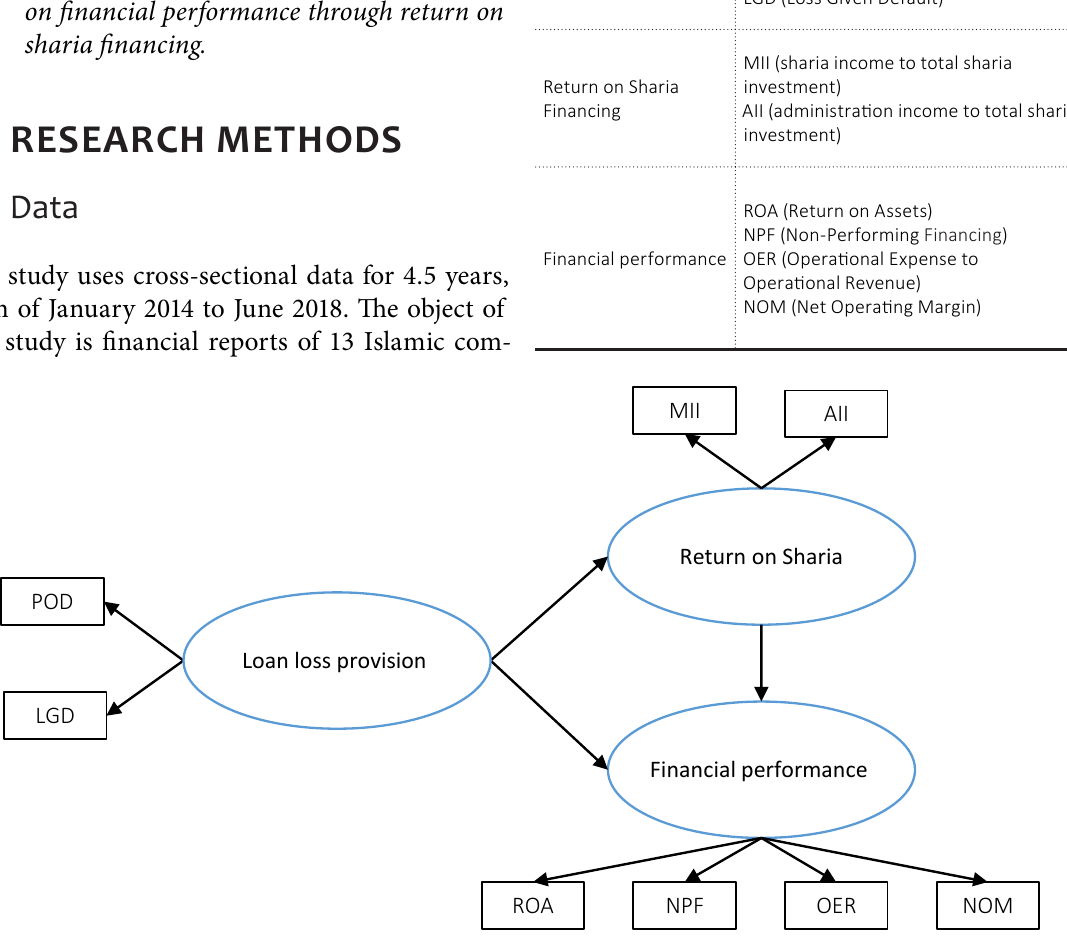
Figure 1. Path diagram